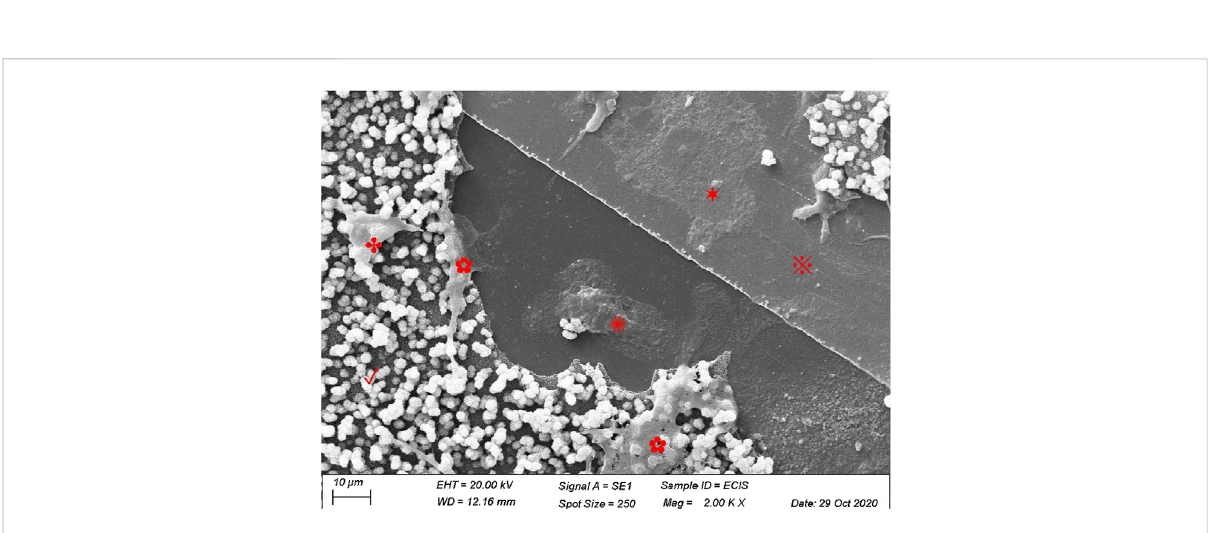
Human osteoclasts on CAP-coated ECIS plates. Human CD14+-cells were cultured for 21 days with M-CSF and RANKL and visualized by scanning electron microscopy. The image shows a partly intact CAP ( ✓ ) layer on the culture surface of ECIS wells. Some osteoclasts have lysed the CAPcoating,exposingtheelectrode( ※ ).Severalosteoclastswerepresentonthebaremulti-wellplasticsubstrate( ✺ ),ontheelectrode( ✶ ),aswellas osteoclasts that partially lysed CAP ( ✿ ), and an osteoclast still on top of the CAP coating ( ✤